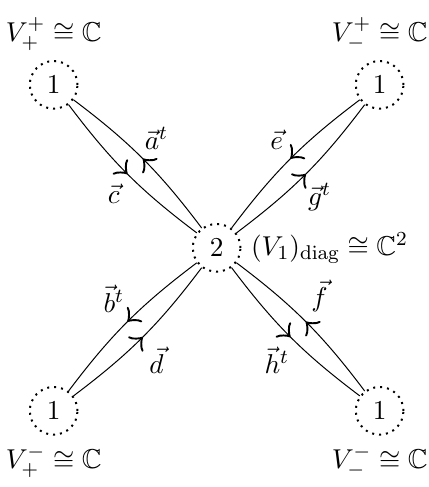
Figure 1 . c D 4 quiver diagram. Each link is labeled by the bifundamental (cid:12)eld mapping between representation spaces. The four row vectors ~a t ;~b t ;~g t ;~h t are in the representation (2 ; 1) of U(2) (cid:2) U(1), while the four column vectors ~c; ~ d;~e; ~ f are in the representation (1 ; 2) of U(1) (cid:2) U(2). Since all of the bifundamental hypermultiplets are organized in the 8 (cid:2) 8 matrix Q , the matrix e Q provides redundant